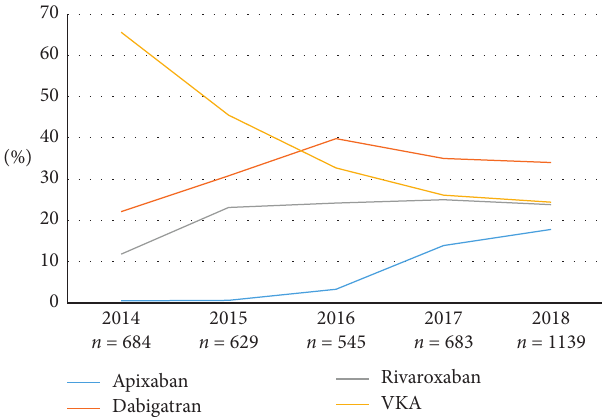
Figure 2: Proportion of patients treated with oral anticoagulants in particular years of